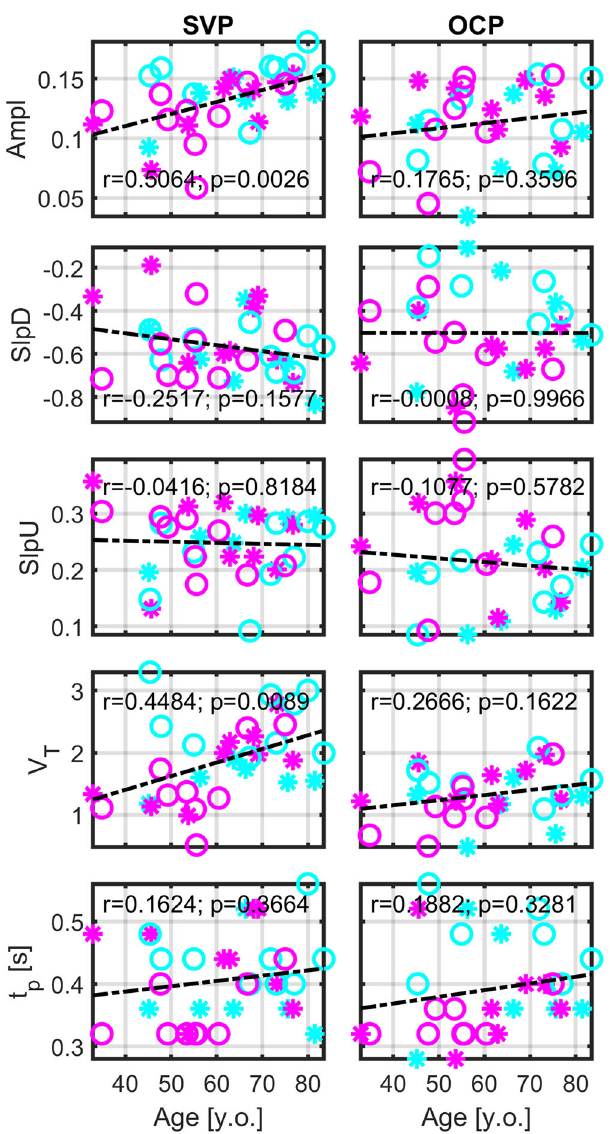
Fig. 5 Evaluation of linear dependence between age and morphology of retinal pulsatile patterns. Value r represents a corresponding Pearson correlation coef fi cient and value p is the p -value of the correlation level.